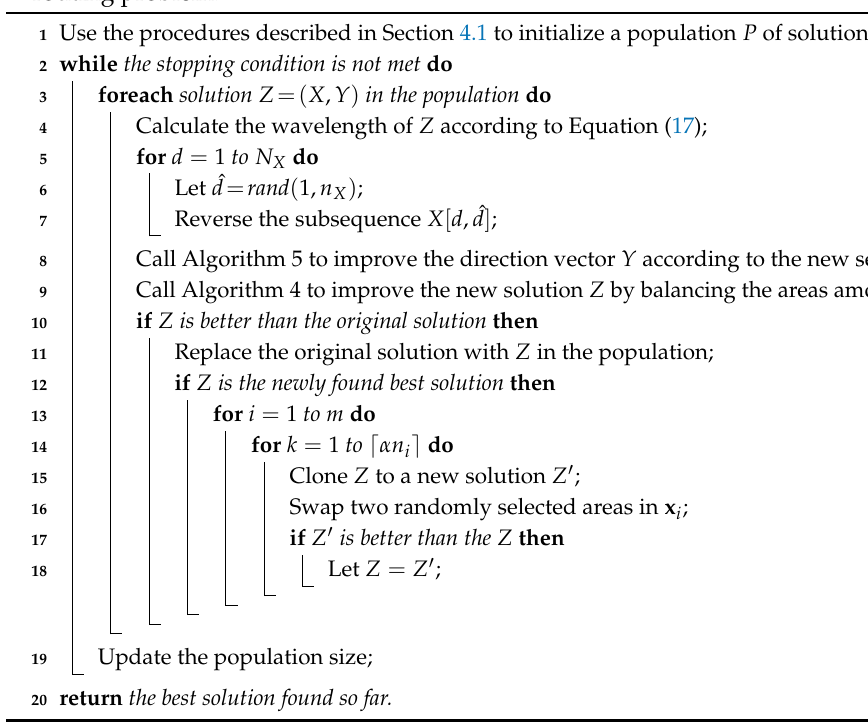
Algorithm 1: The hybrid WWO and neighborhood search algorithm for the quarantine vehicle routing